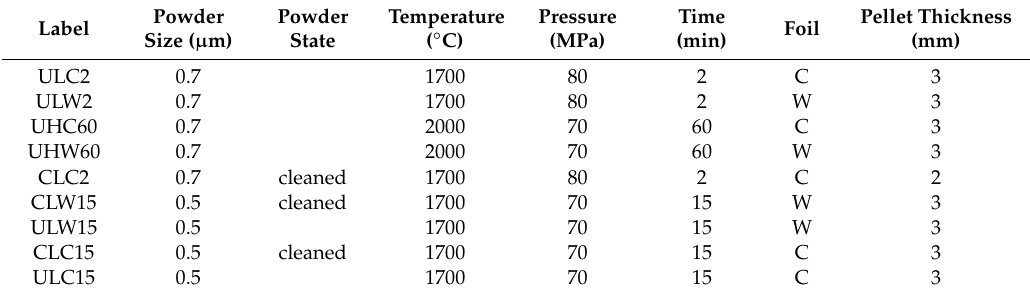
Table 1. Overview of the samples and preparation conditions. In the sample labels, the first letter designates the powder state (C = cleaned, U = uncleaned), second letter the sintering temperature (L = low, H = high), third letter the foil type (C = graphite, W = tungsten) and the number at the end the sintering time in minutes. The powder size in this table is a nominal value provided by the manufacturer; the sizes of individual grains varied, as shown in Figure 1.